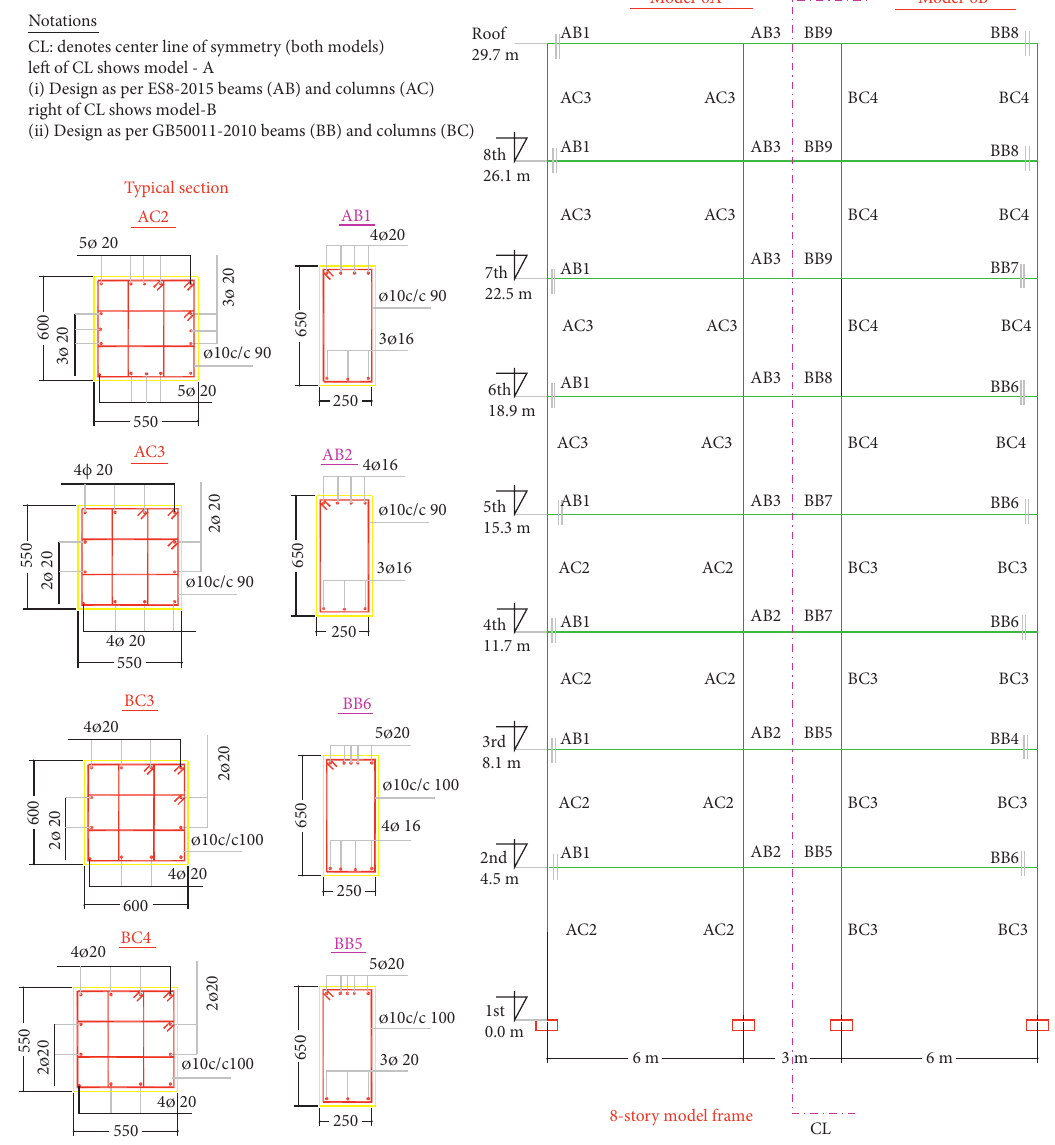
Figure 4: Reinforcement design diagram 8-story RC frame designed as per ES8-15(8A) and GB11-10 (8B). Table 2: Beam and column section reinforcement design of 8-story frame in Figure